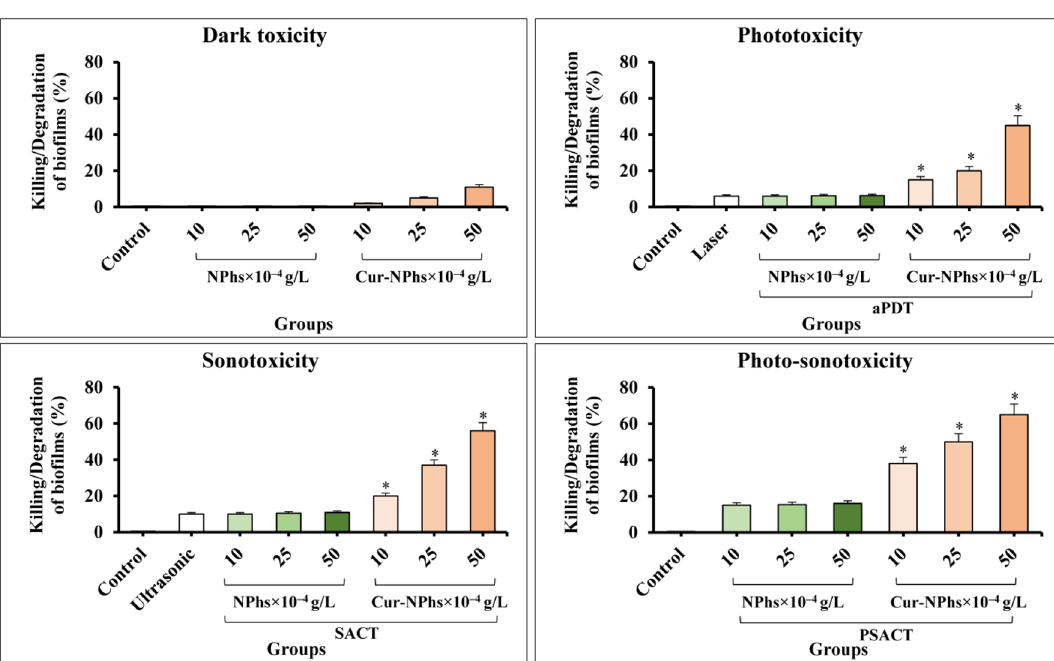
Figure 6. Biofilm degradation ability of A. actinomycetemcomitans following different treatments. Significant differences according to the control, *P <